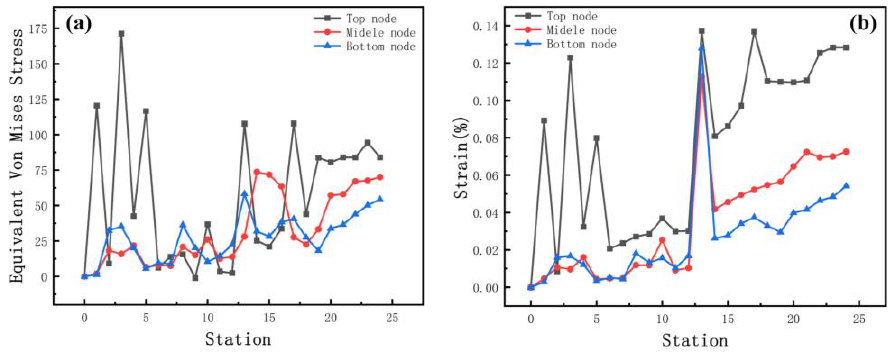
Figure 8. ( a ) Stress and ( b ) strain curves at different positions of the strip edge.